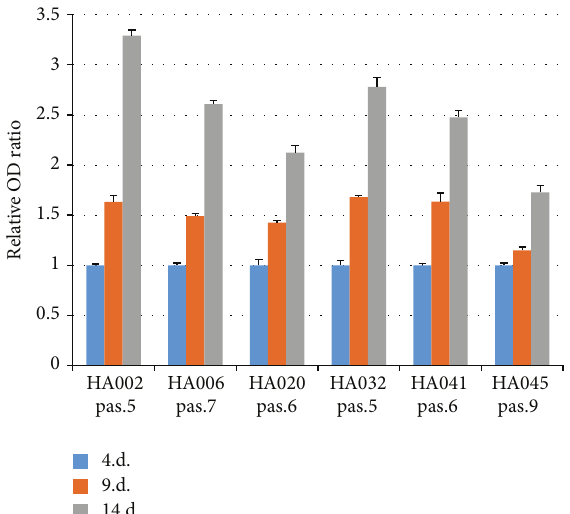
Figure 2: Proliferation rate of the cells isolated from pituitary adenoma samples. Cell cultures were evaluated at passages (pas.) 5–9. Values are mean ± SD from two experiments performed in